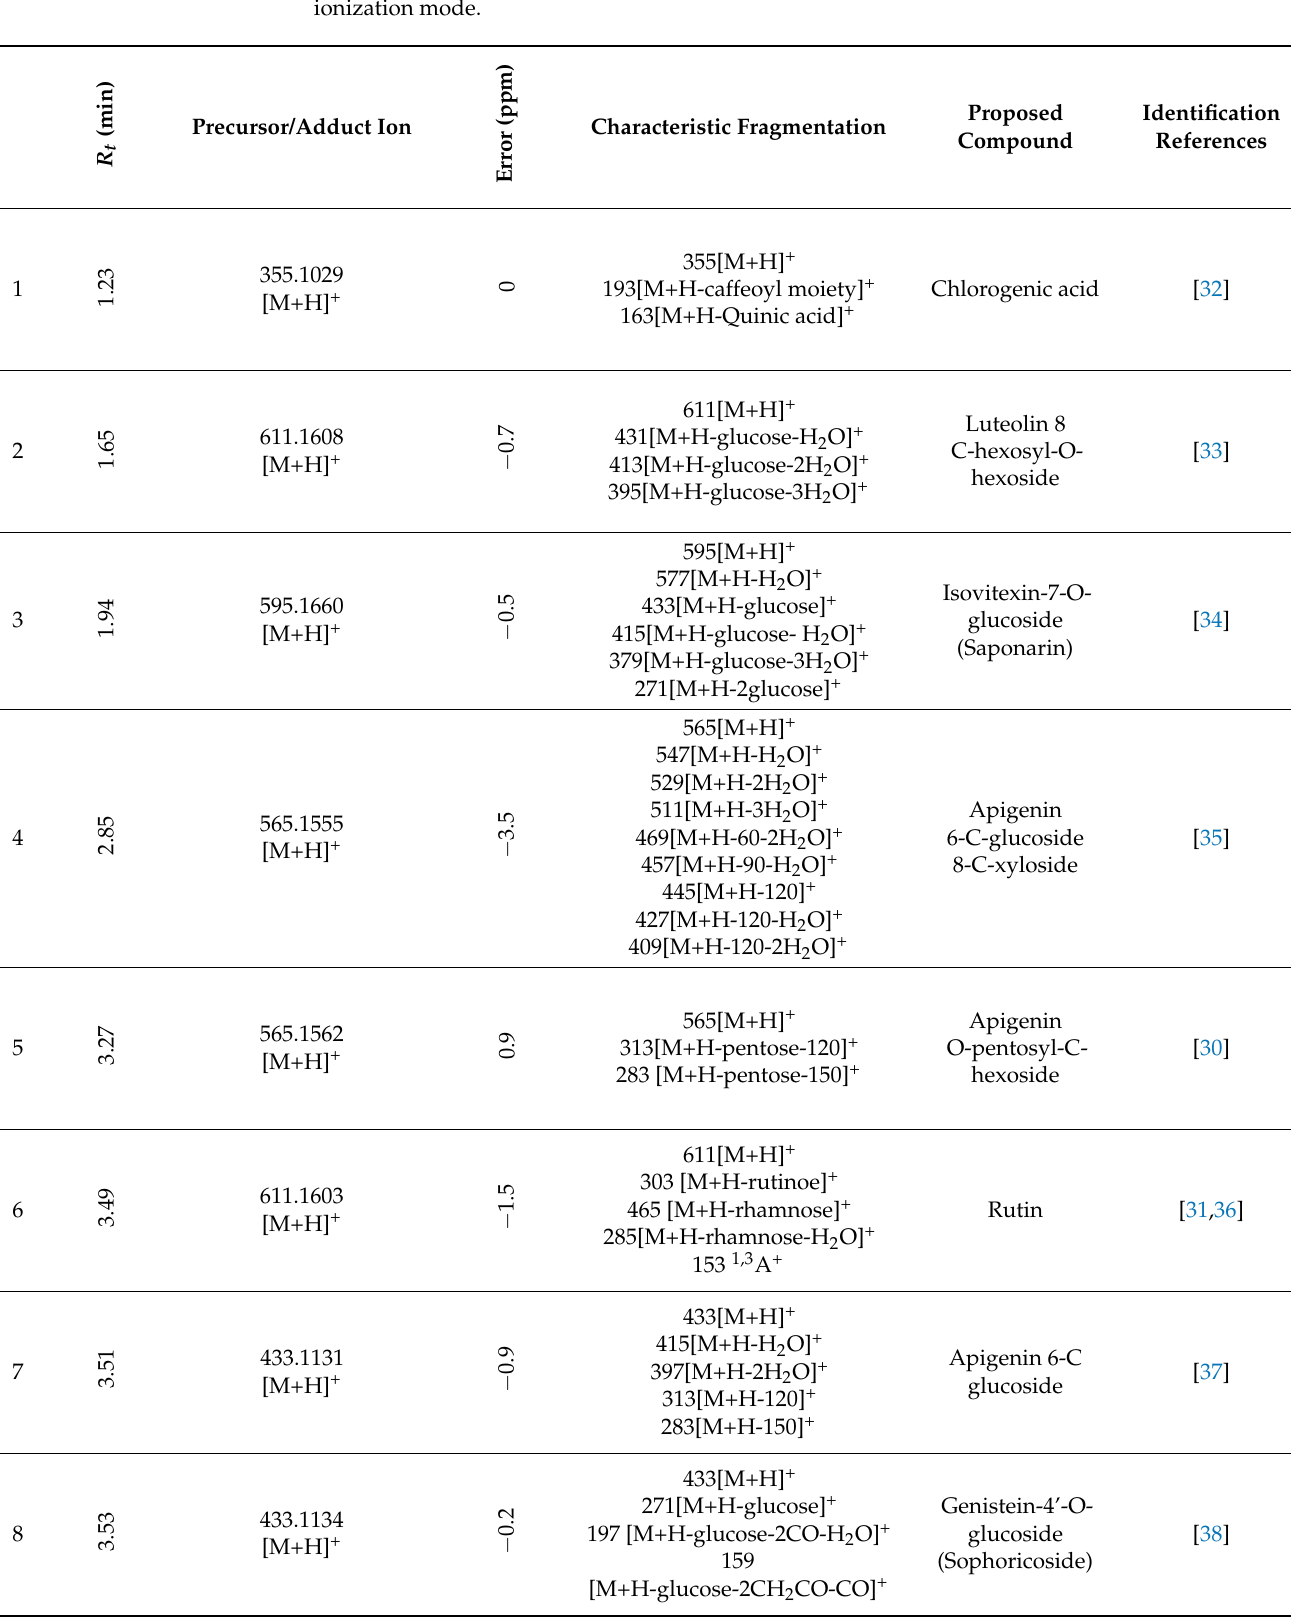
Table 2. DRE bioactive constituents identified using UHPLC/QTOF-MS/MS analysis in positive ionization